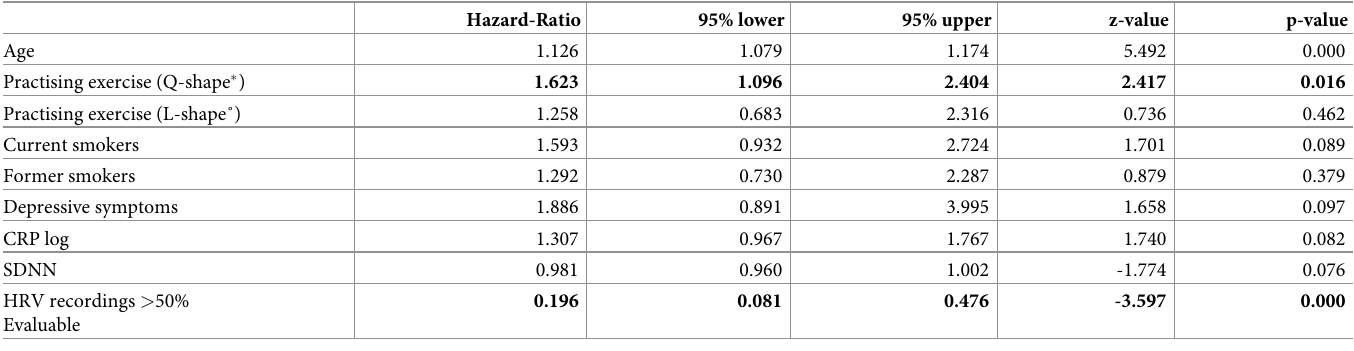
Table 4. Model for controls after 26